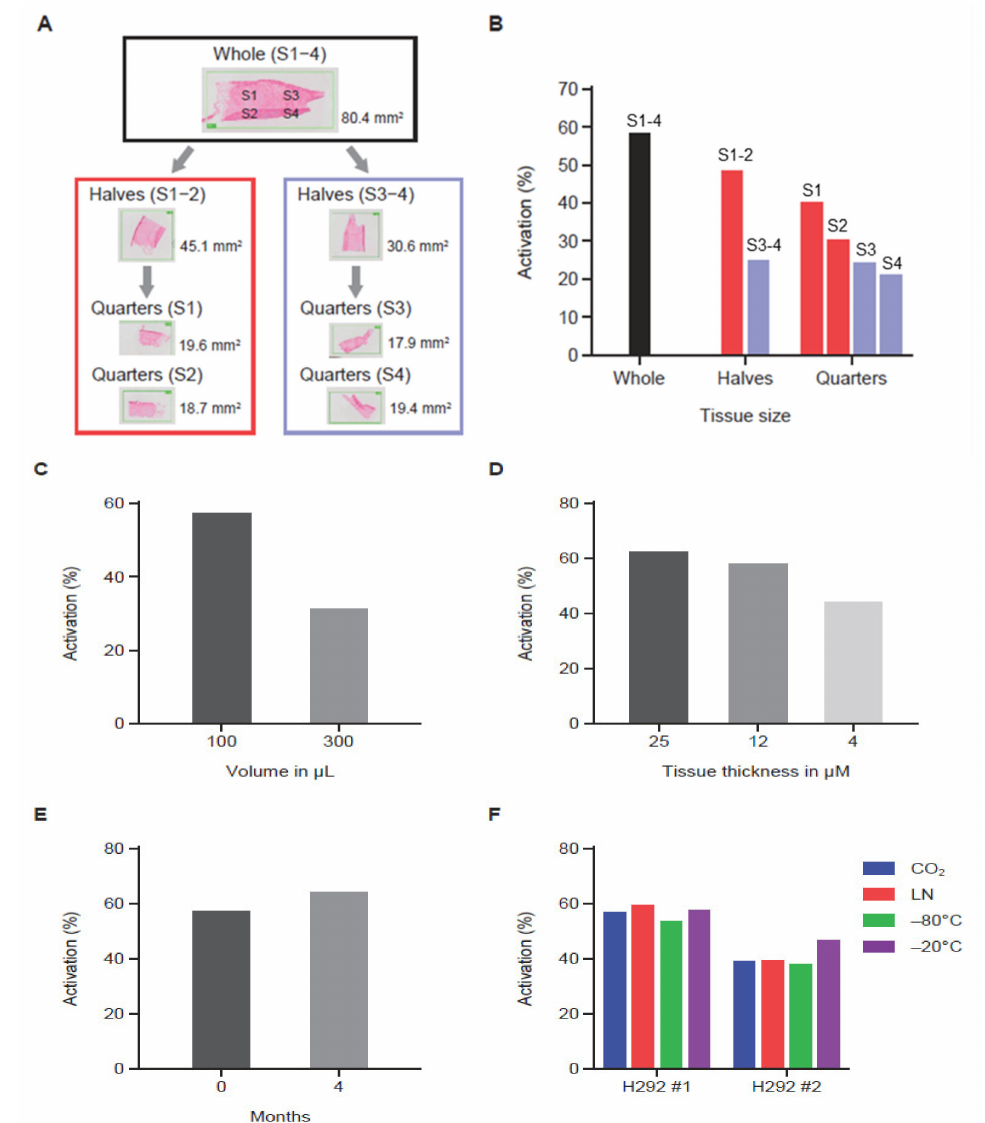
Figure 3. The effect of experimental variables on the quantitative zymography (QZ) assay. ( A ) Diagram showing tissue partitioning into halves and quarters prior to QZ activity assessment. ( B ) QZ assay of a tissue sample assessed at different section sizes using a constant assay volume (100 µ L). As the tissue was halved and quartered, decreased activity was observed. ( C ) QZ assay of a tissue sample assessed in different assay volumes (100 µ L and 300 µ L) showing correlation of assay volume with activity. ( D ) QZ assay of tissue sections of different thickness in a fixed volume showing correlation of tissue thickness with activity. ( E ) QZ assay before and after tissue storage at − 80 ◦ C for 4 months showing preservation of activity after storage. ( F ) QZ assay of tissue samples subjected to different freezing techniques and storage temperatures. Samples frozen using dry ice (CO 2 ), liquid nitrogen (LN), or − 80 ◦ C temperature were stored at − 80 ◦ C. Samples frozen using − 20 ◦ C temperature were stored at − 20 ◦ C. Activity was similar regardless of freezing condition and storage temperature. For data shown in panels ( B – E ), the Sub1 Probody therapeutic (Pb-Tx) was used, while for panel ( F ), the Sub2 Pb-Tx was used. The incubation time for data shown in panels ( B – D ) was 24 h. The incubation time was 48 h for data shown in panels ( E , F